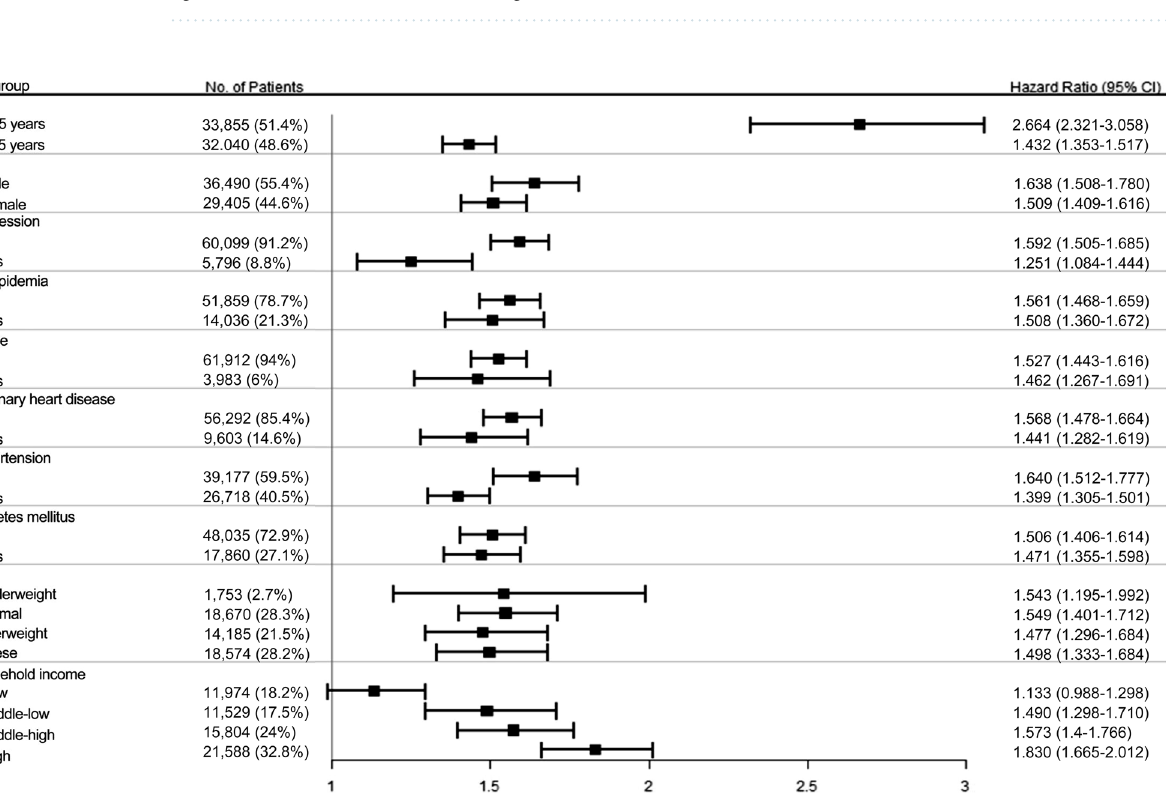
Table 2. Impact of VI on the risk of dementia via multivariable time-varying Cox regression analyses. VI = visual impairment; CI = confidence interval; HR = hazard ratio. a Adjusted for age and sex. b Adjusted for age, sex and all interactions between age, sex and VI.